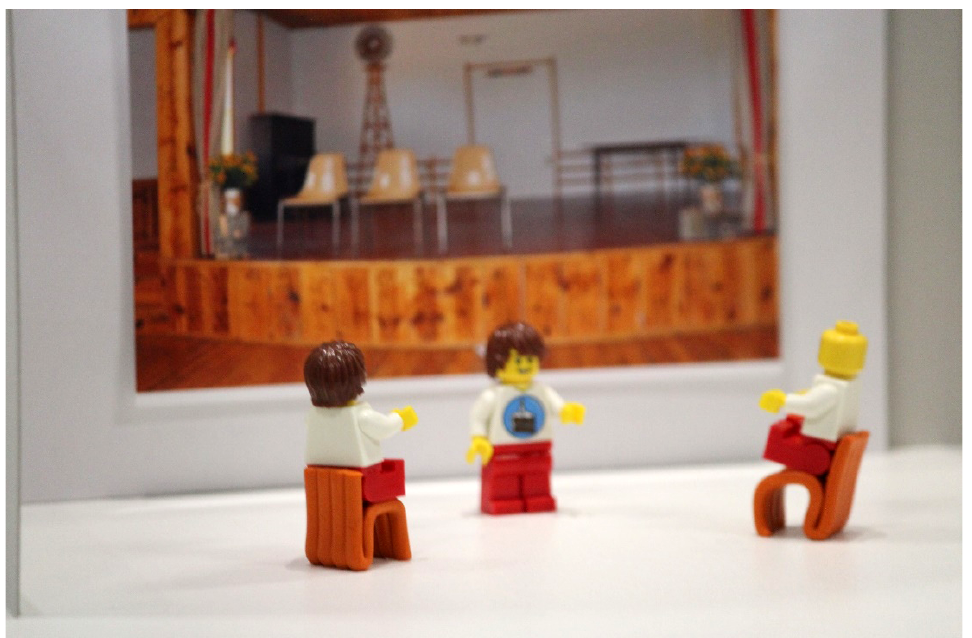
Figure 5. “Status Quo” scenario. Photograph by Danielle